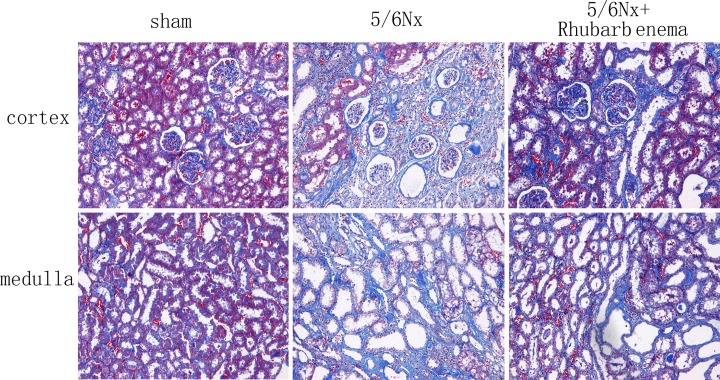
Pathological findings in sham and 5/6Nx rats treated with and without rhubarb enema (Masson’s stain, ×100).